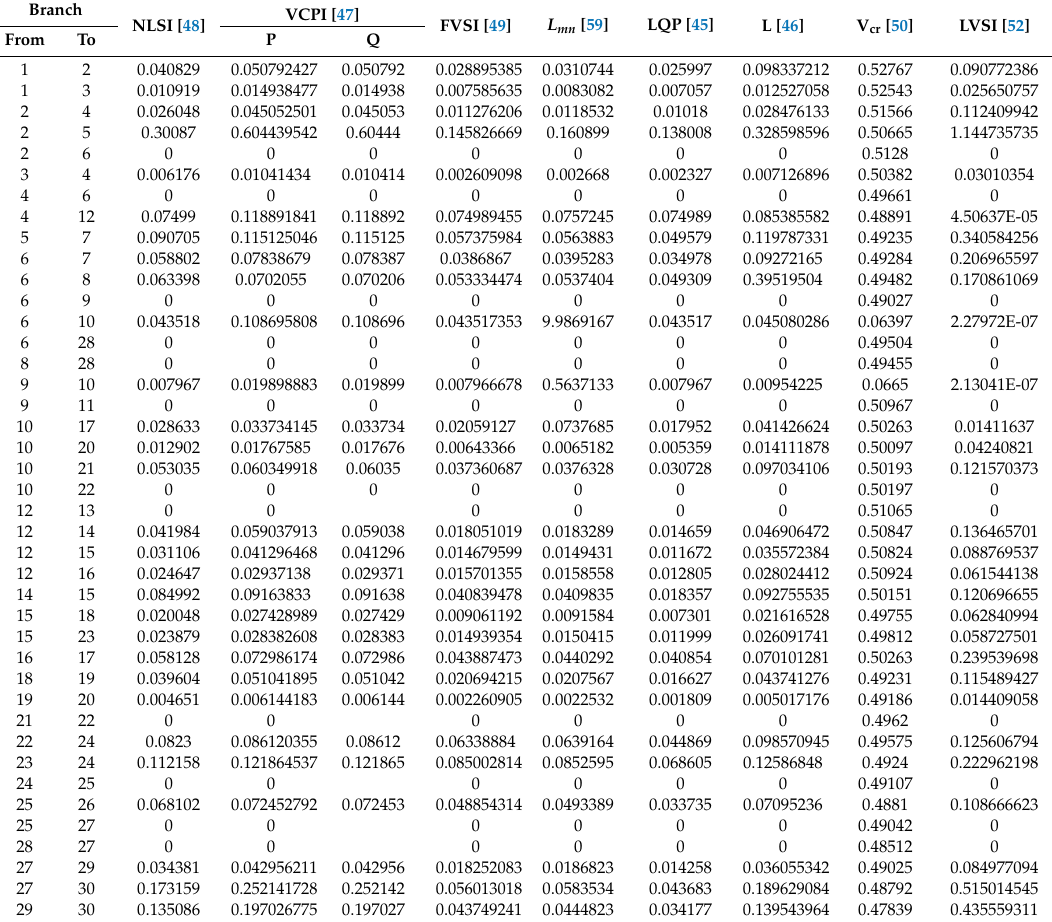
The obtained indices’ magnitude for critical branch identification by each index (IEEE 30-bus